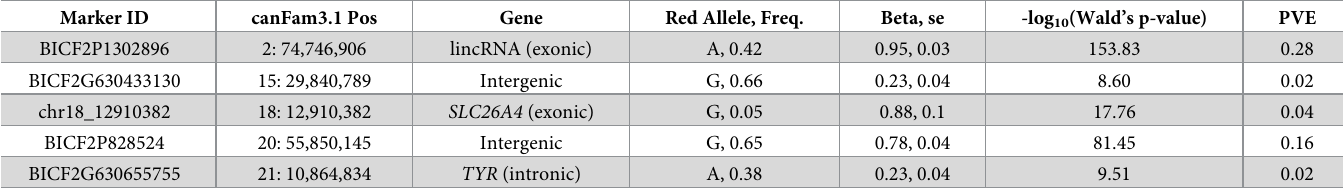
Table 1. Top GWAS markers at five associated